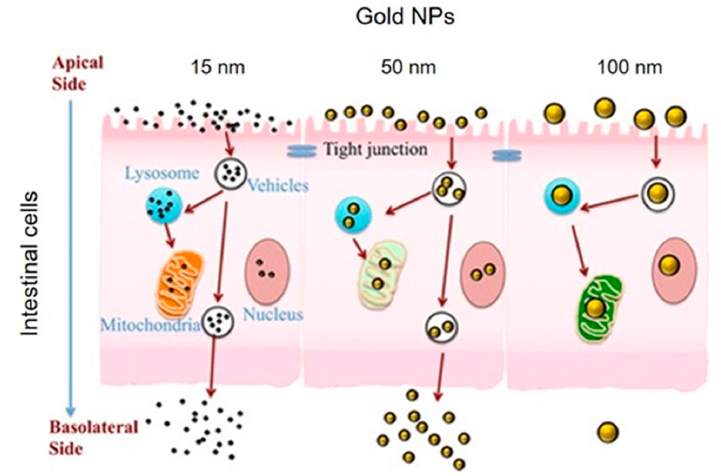
Figure 2. Relationship between AuNP size and uptake across intestinal cells. AuNPs of 15 nm were absorbed by the intestinal epithelial and spread quickly throughout and into cells. AuNPs of 50 nm crossed the apical side of the intestinal epithelium and were excreted via the basolateral side. AuNPs of 100 nm accumulated in intestinal cells and consequently the excretion route is very low. Reprinted (adapted) with permission from reference [46]. Copyright (2015), American Chemical Society.